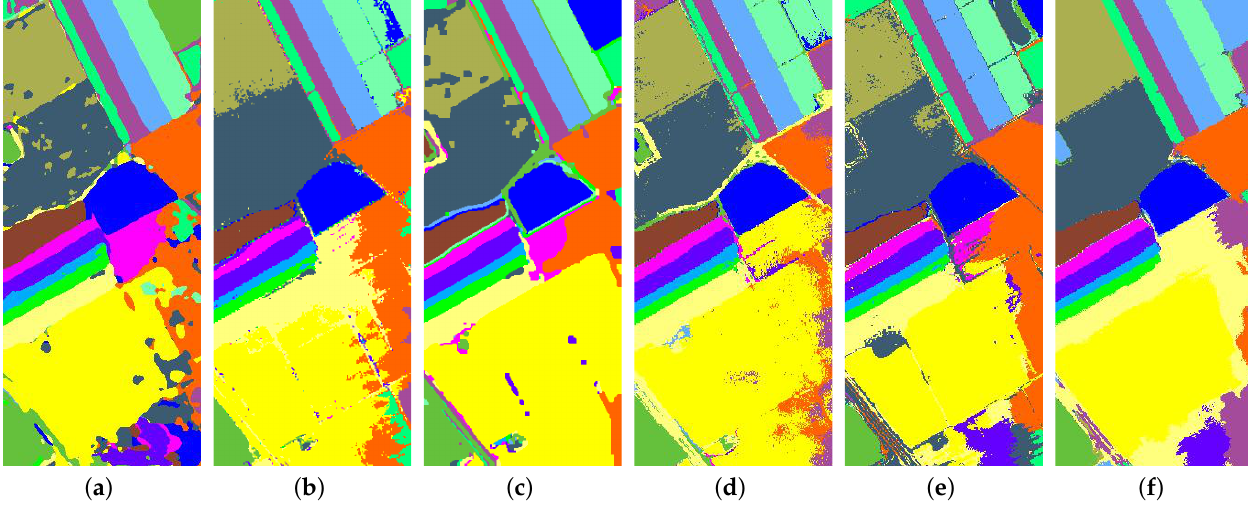
Figure 14. Classification maps for the Salinas data set using different methods. ( a ) HybridSN; ( b ) STSE_DWLR; ( c ) CNN-MRF; ( d ) LCMR; ( e ) RPNet; ( f ) SANet.